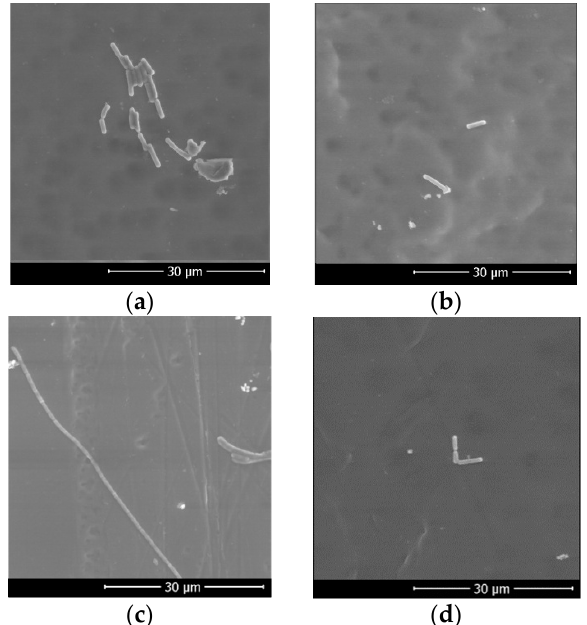
Figure 9 . Escherichia coli attachment to the membrane surface: ( a ) Pristine CA membrane (DMAc); ( b ) 1.0 wt% CPHE/CA composite membrane (DMAc), ( c ) Pristine CA membrane (DMF) ( d ) 1.0 wt% CPHE/CA composite membrane (DMF).